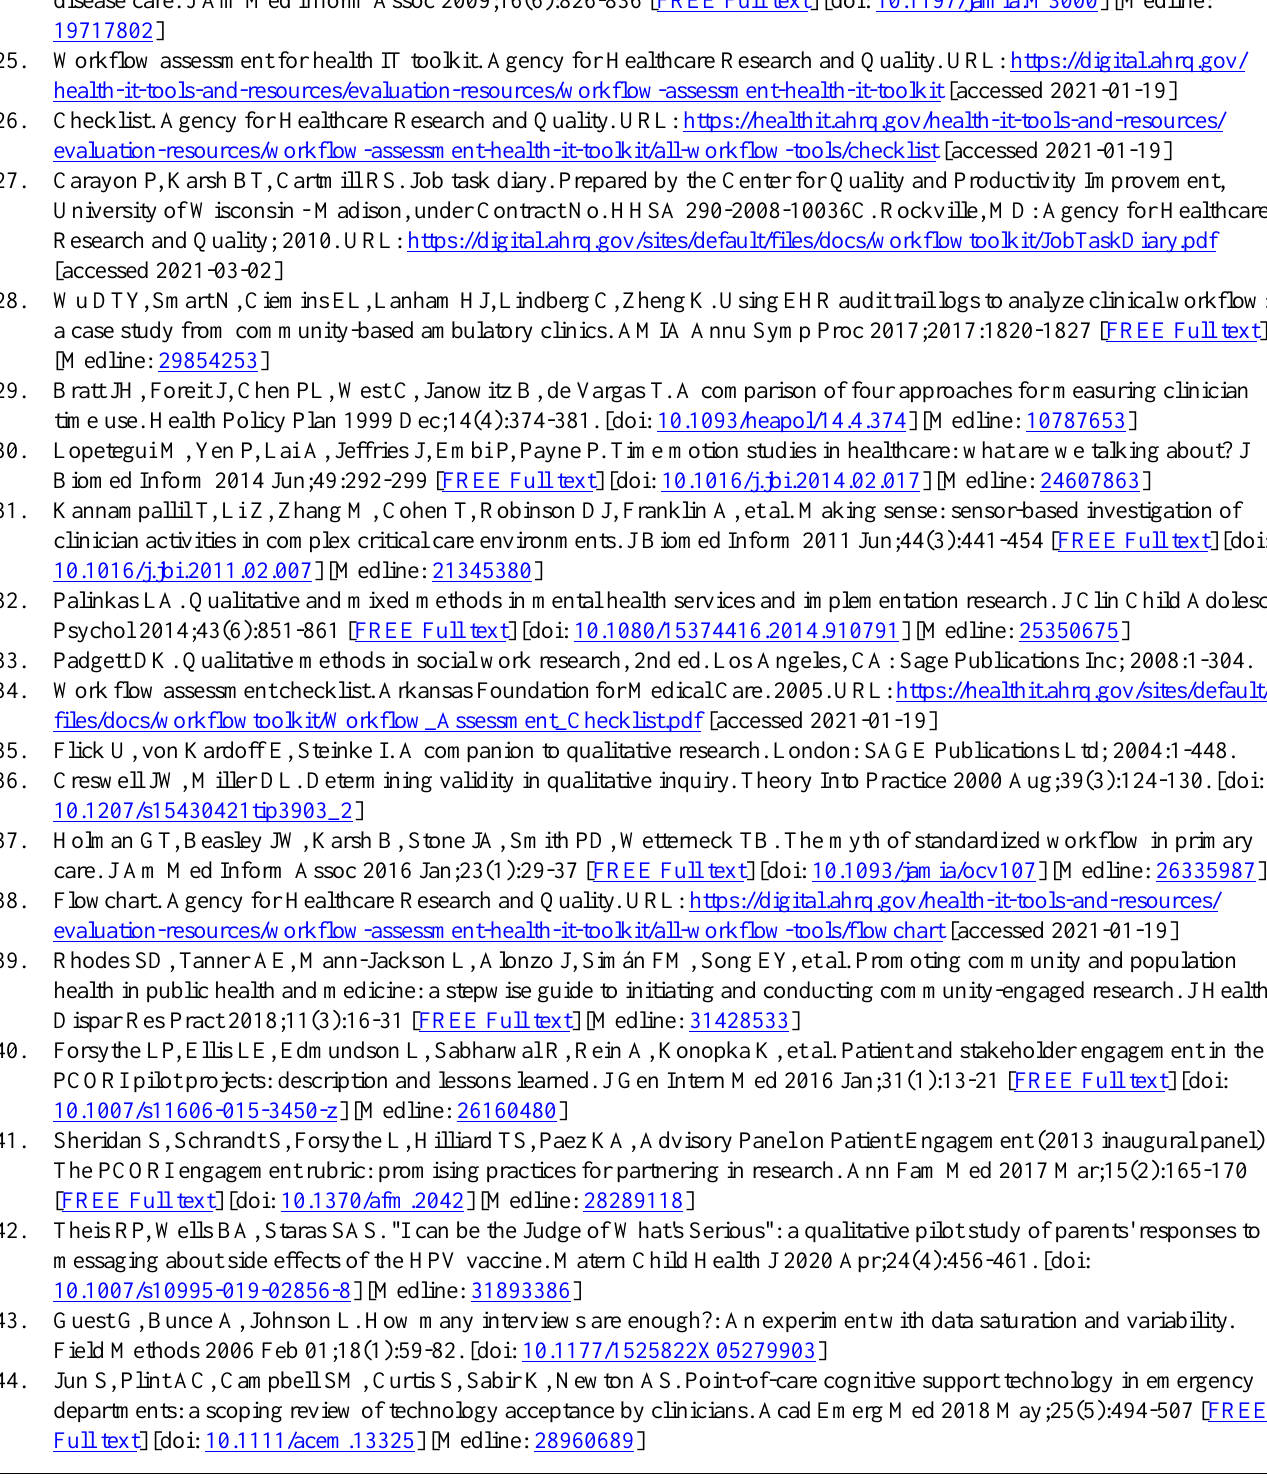
AHRQ: Agency for Healthcare Research and